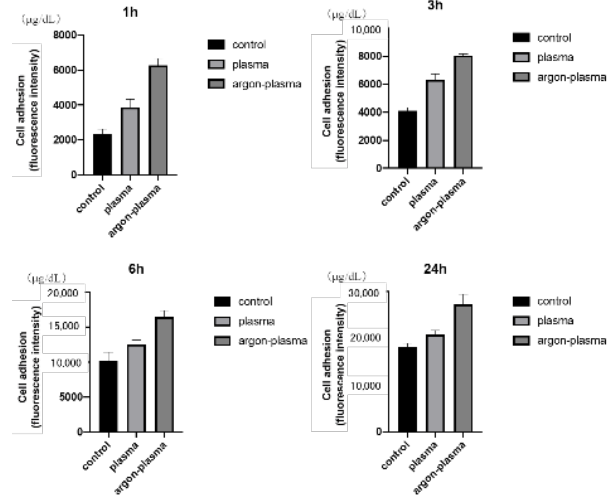
Figure 5. After argon-plasma treatment on the material surface, the number of adhered RBMCs was statistically significantly higher than that in the control group. In addition, the highest value was observed in the argon plasma treatment group, among all three groups. At all measurement time points, the adhesion number of RBMCs in the argon plasma-treated group was significantly the highest among all three groups.